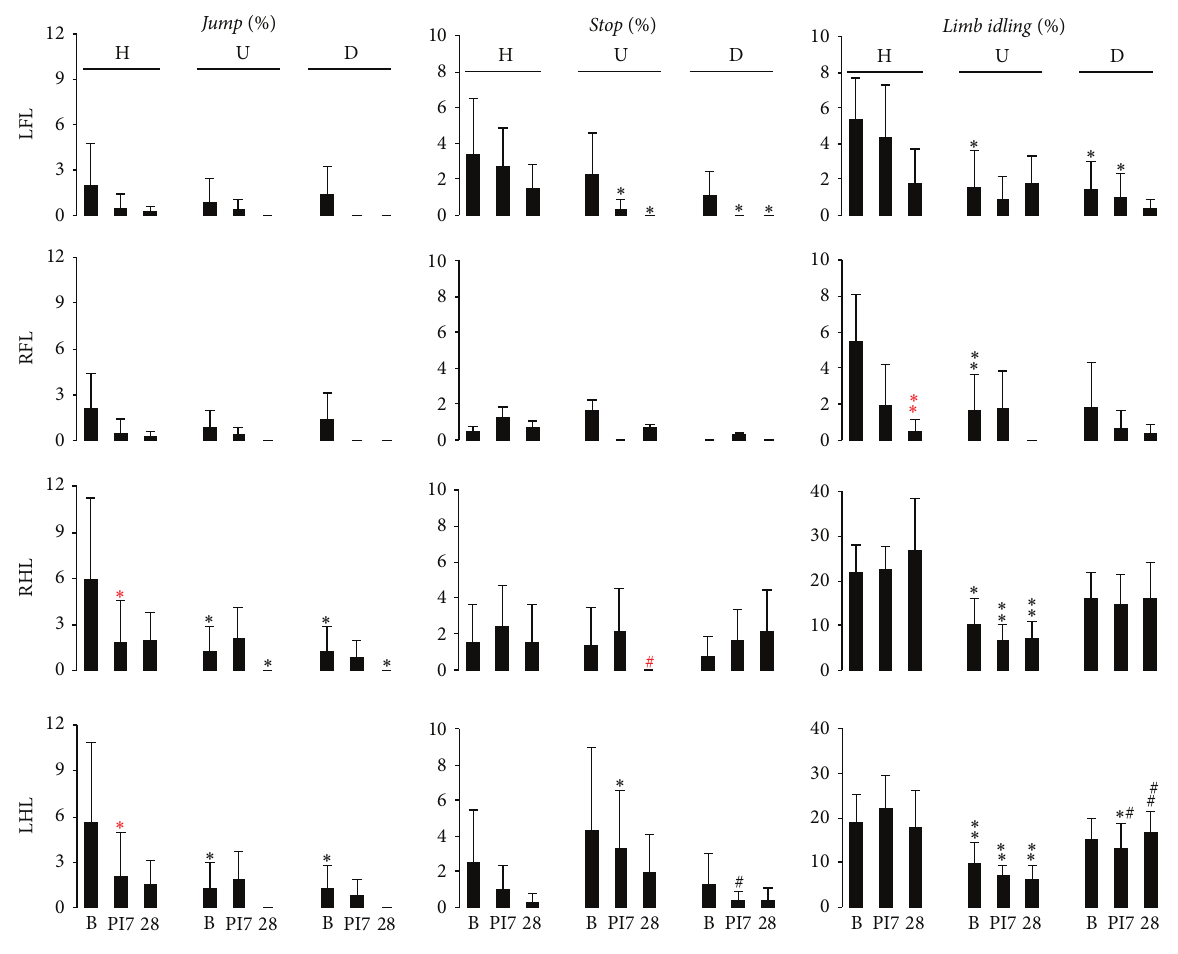
Figure 3: Modes of limb use in inclined rung ladder walking. Frequency of occurrence of the categories for limb use: jumps, stops, and limb idling were analyzed for each limb in horizontal (zero inclination), upward, and downward walking across the rung ladder before and after photothrombotic lesion. Lesion was performed in the respective areas of the motor cortex of both the right forelimb and hind limb. In horizontal walking, photothrombosis resulted in an increased use of the impaired forelimb, and modes of limb use differed between the tasks. H: horizontal ladder, U: upward ladder, D: downward ladder, B: baseline, PI 7: postischemic day 7, PI 28: postischemic day 28, LFL: left forelimb, RFL: right forelimb, RHL: right hind limb, LHL: left hind limb. one red star 𝑃 < 0.05 , two red stars 𝑃 < 0.01 versus baseline, red # P < 0.05 versus PI 7; ∗ P < 0.05, ∗∗ P < 0.01 versus H, # P < 0.05, ## P < 0.01 versus